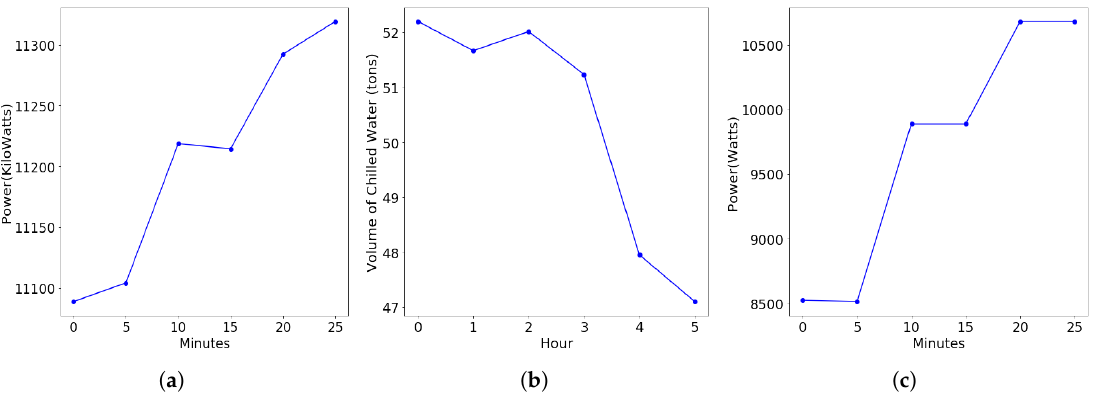
Figure 2. Different loads for a short duration of time. ( a ) Aggregate Electricity Load of Carnegie Mellon University; ( b ) Cooling load for Y2E2 building in Stanford Campus; ( c ) Lighting load for Y2E2 building in Stanford